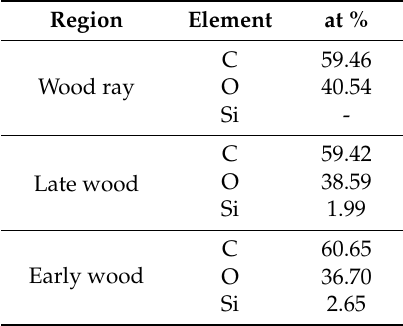
Table 1. Results of EDX area-measurements, as shown in Figure